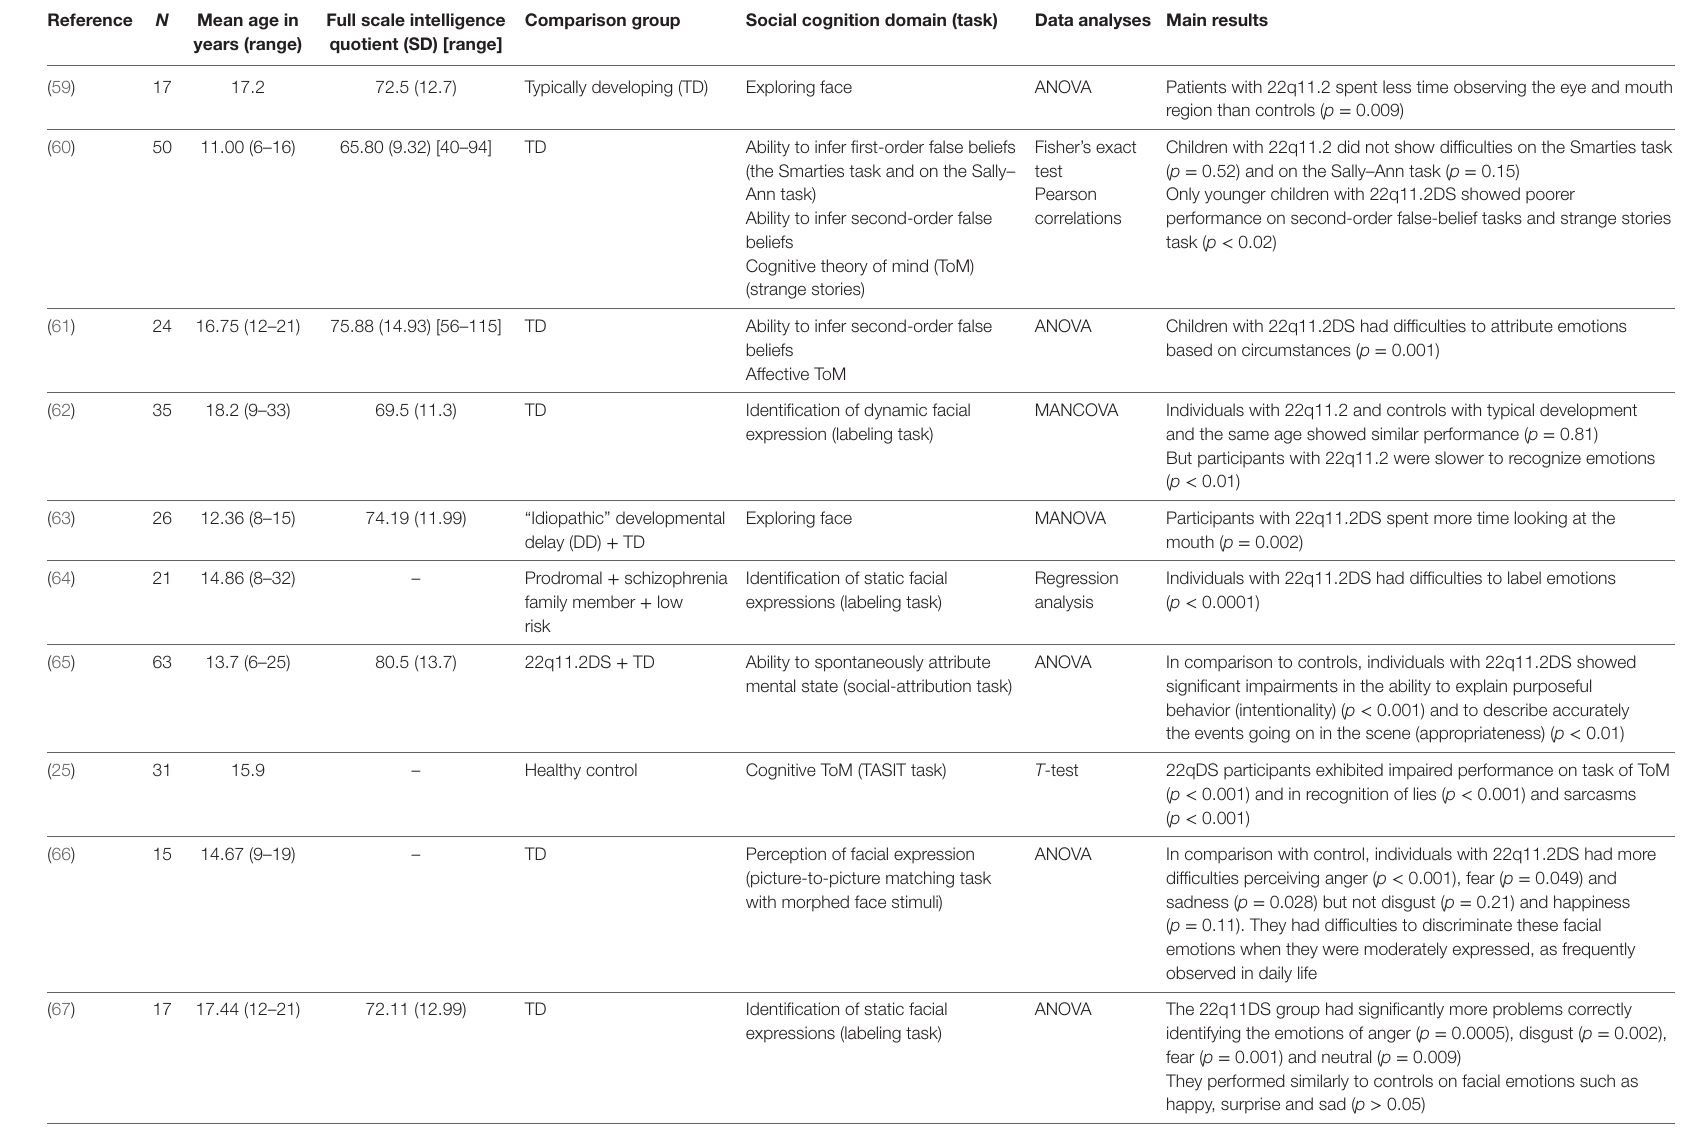
TAbLe 2 | Fourteen studies examining social cognition in 22q11.2 deletion syndrome (22q11.2DS). Reference N Social cognition domain